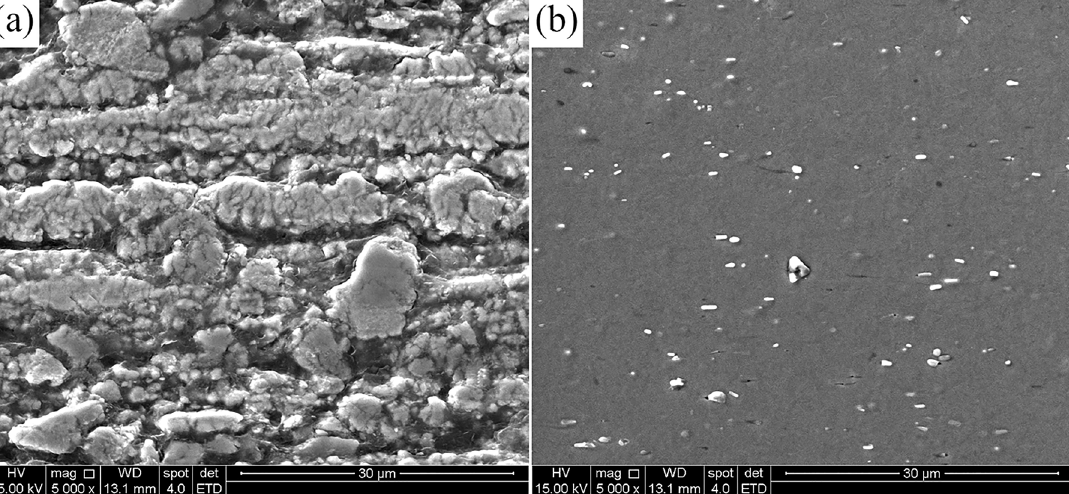
Figure 9. Surface morphologies of shape memory NiTi wires after potentiodynamic polarization in Hank's solution: (a) as received and (b)